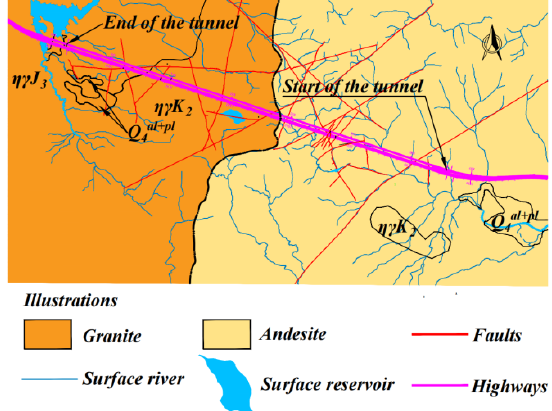
Figure 2. Distribution of fracture structures in the tunnel site area (1:10,000).